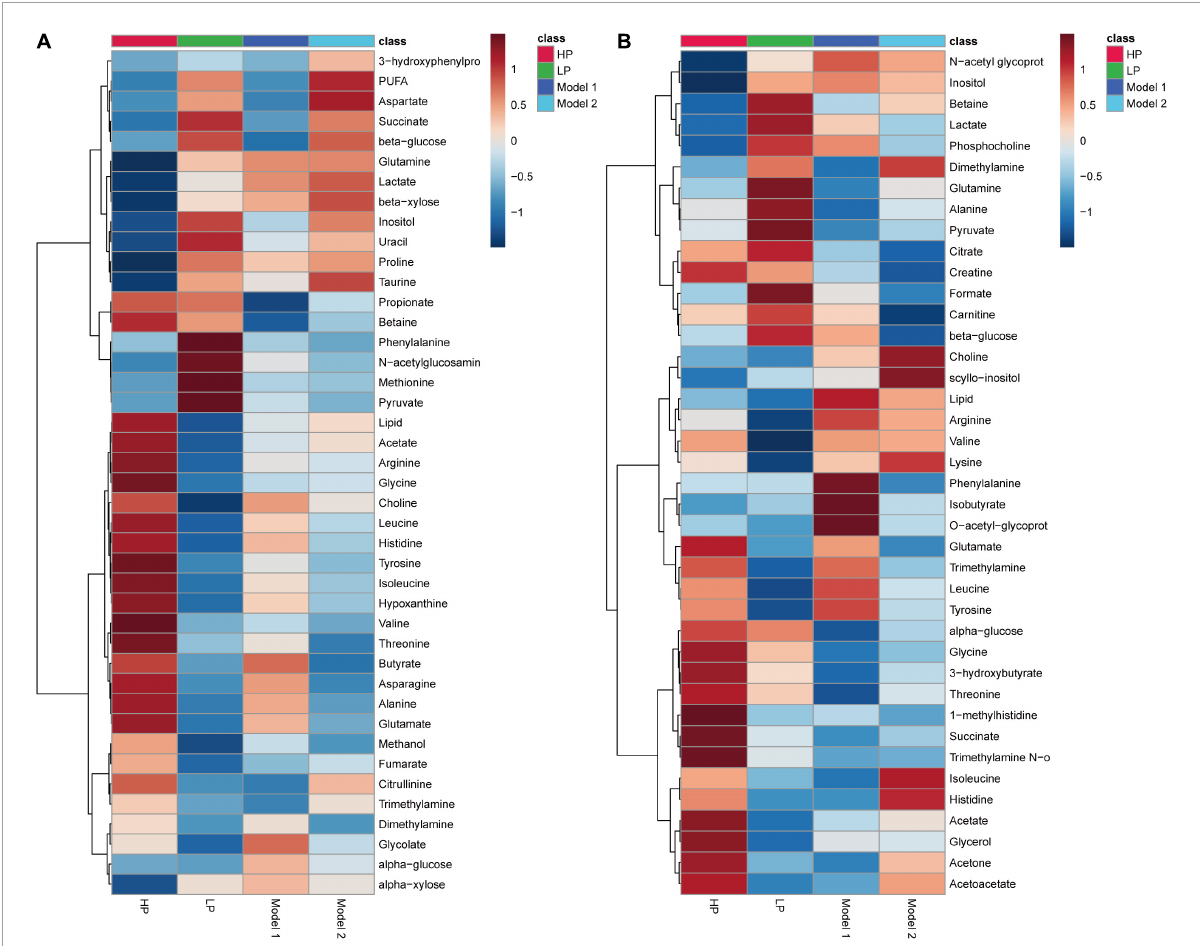
FIGURE4 Hierarchical clustering heatmap of metabolite concentrations. (A) Hierarchical clustering heatmap of metabolite concentrations in rat feces. (B) Hierarchical clustering heatmap of metabolite concentrations in rat